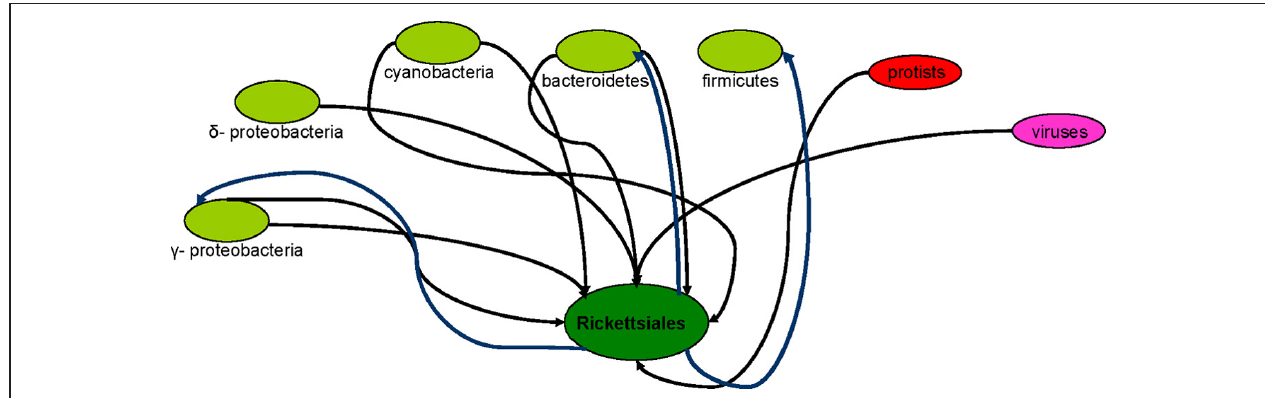
FIGURE 2 | The rhizome of bacteria—the Rickettsiales paradigm. Rickettsiales harbor genes from various bacterial species, protists, and viruses.